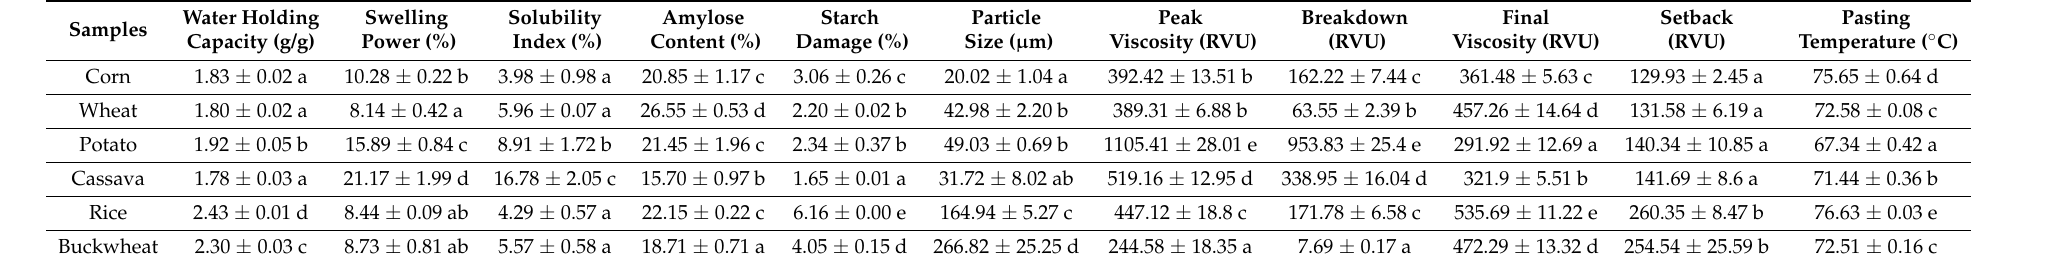
Table 1. Chemical and physical characterization of different starches and flours used for baking.